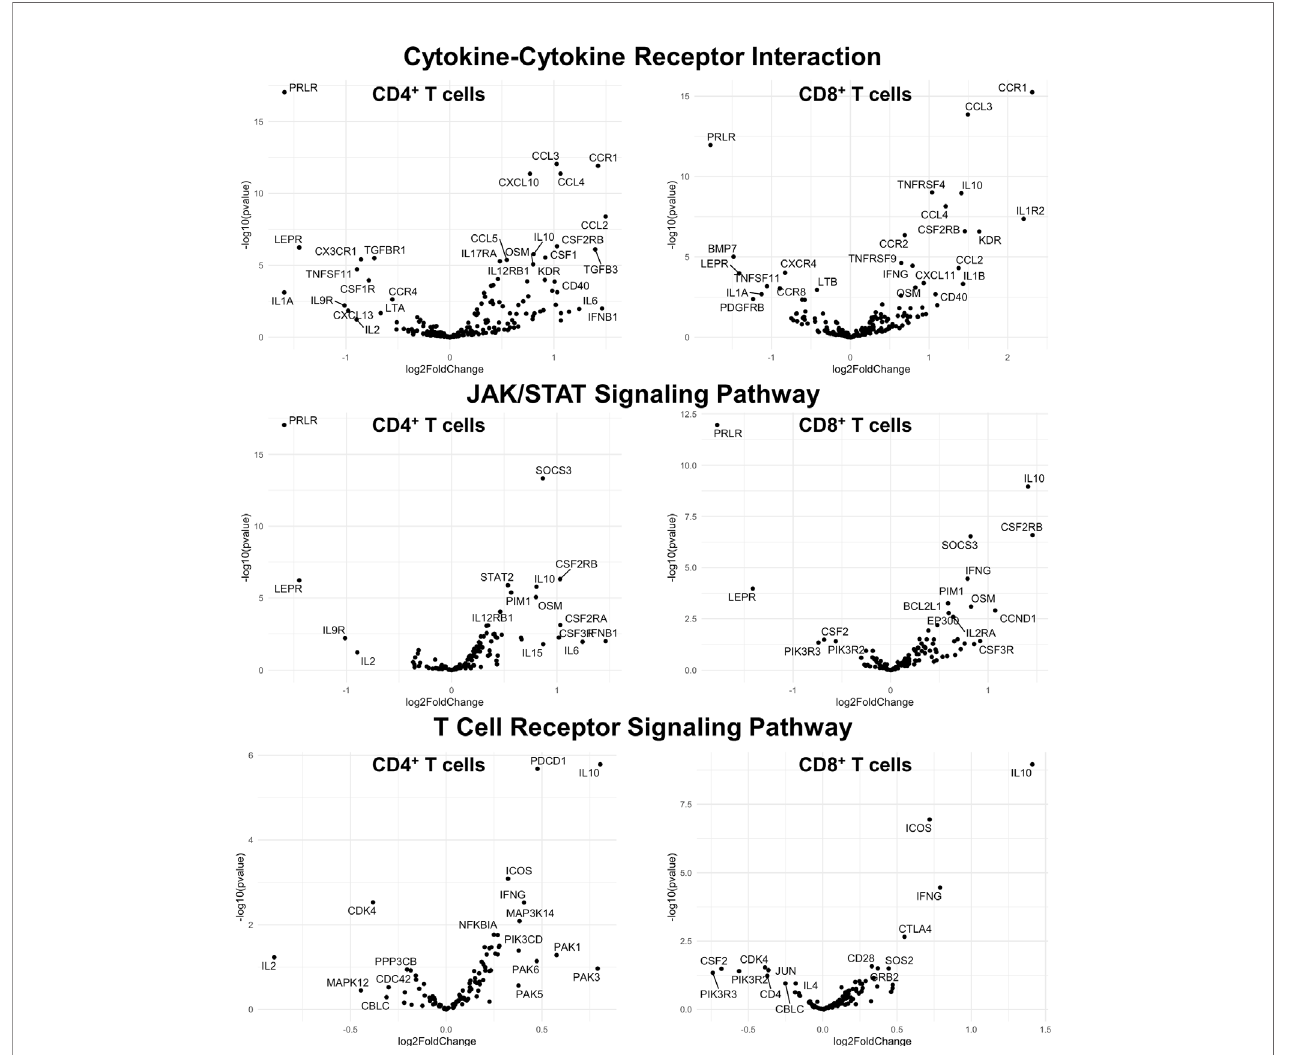
FIGURE 8 | Genes related to cytokine-cytokine receptor interaction, JAK/STAT signaling, and T cell receptor signaling are enriched in CD4 + and CD8 + T cells from the CNS of microglia-de fi cient B6J mice compared to microglia-competent B6J mice. C57BL/6J mice were treated with a PLX5622-supplemented or control diet seven days prior to i.c. TMEV infection and sacri fi ced at 6 DPI for analysis (n = 10 mice per group). Volcano plots of RNA-seq transcriptome data displaying gene expression within the indicated KEGG pathways of enriched CD4 + and CD8 + T cells from the CNS of microglia-de fi cient C57BL/6J mice relative to microglia- competent C57BL/6J